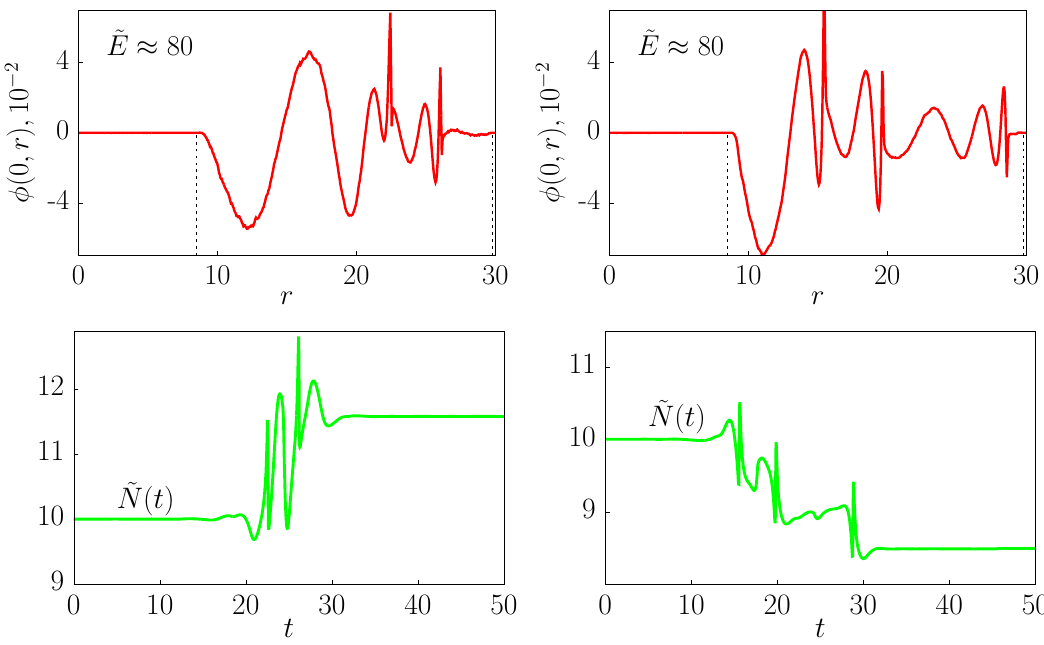
Figure 15 . The initial wave packets (left panels) and evolution of the instantaneous particle number (right panels) for the solutions with ~ N i = 10 and ~ E (cid:25) 80 corresponding to local minima of ~ N f . Upper and lower panels correspond to